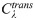
Communication cost trade-off within subjects.(a) Correlations between all subject’s Cλtrans across all values of λ. Positive correlations are colored in red, negative correlations are colored in blue. (b) Eight subject’s Cλtrans and Cλinfo curves after normalization with respect to the max(Cλtrans) and max(Cλinfo), respectively. Notice how some subject’s Cλtrans curves decay faster than others, and how some subject’s Cλinfo curves grow faster than others. (c) Scatter plot of the computed areas under the normalized Cλtrans and Cλinfo curves, sowing a trade-off between the decay of Cλtrans and the growth of Cλinfo (the correlation between A(Cλtrans) and A(Cλinfo) is r = -0.74, p < 0.001).